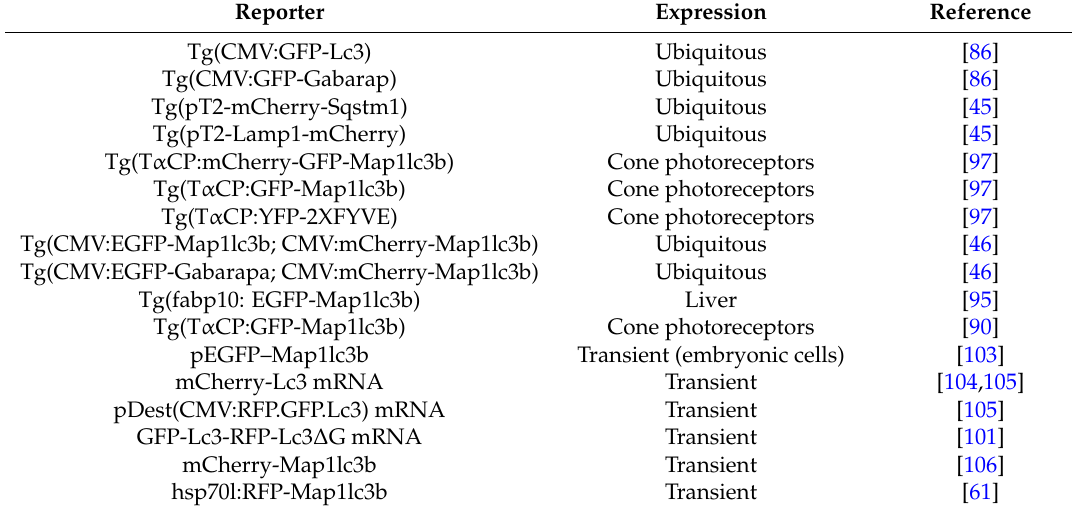
Table 2. Constitutive and transient reporter constructs used to study autophagy in